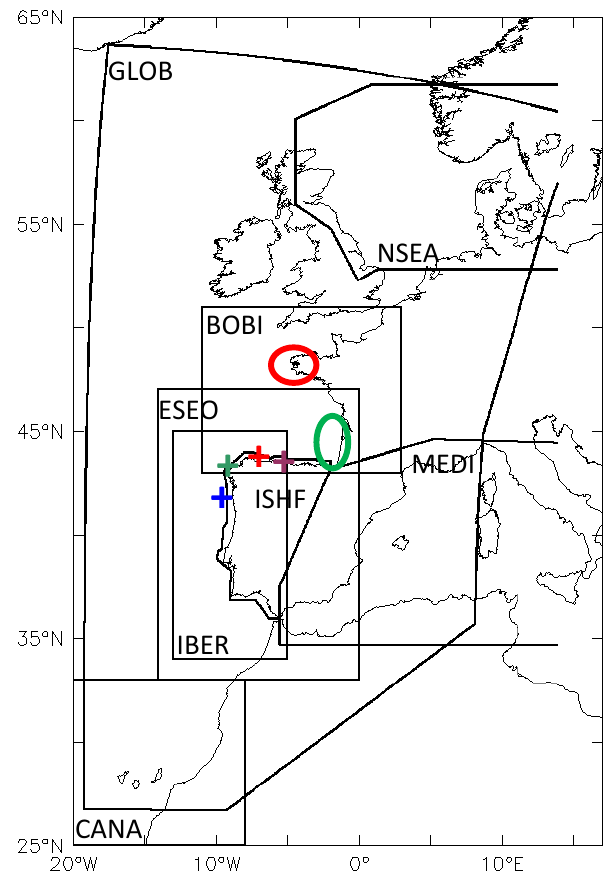
Figure 7: Map of IBI area with boxes where statistics have been calculated:Bay of Biscay region (BOBI: 11°W-3°E, 43°N-51°N), the Canary Islands region (CANA: 21°W-8°W, 25°N-33°N), the Fig. 7. Map of IBI area with boxes where statistics have been cal- culated: Bay of Biscay region (BOBI: 11 ◦ W–3 ◦ E, 43–51 ◦ N), the ESEOAT region (ESEO: 14°W-0°E, 33°N-47°N), the Iberic Peninsula region (IBER: 13°W-5°W, 34°N- Canary Islands region (CANA: 21–8 ◦ W, 25–33 ◦ N), the ESEOAT 45°N), the Iberic Peninsula shelf region (ISHF: IBER region over the shelf), the Mediterranean Sea region (ESEO: 14 ◦ W–0 ◦ E, 33–47 ◦ N), the Iberic Peninsula re- region (MEDI: from Gibraltar strait to 9°E), the North Sea region (NSEA: 12°W-14°E, 48°N-62°N) and gion (IBER: 13–5 ◦ W, 34–45 ◦ N), the Iberic Peninsula shelf region the IBI domain region (GLOB). The colored crosses corresponds to the moorings: CaboSilleiro in blue (ISHF: IBER region over the shelf), the Mediterranean Sea region (9.39°W, 42.13°N), Villano-Sisargas in green (9.21°W, 43.5°N), Estaca de Bares in red (7.62°W, (MEDI: from Gibraltar strait to 9 ◦ E), the North Sea region (NSEA: 44.06°N), Cabo de Penas in brown (6.17°W, 43.74°N).The red circle corresponds to the area of the 12 ◦ W–14 ◦ E, 48–62 ◦ N) and the IBI domain region (GLOB). The Ushant front and the green one corresponds to the Aquitaine and the Landes coasts. colored crosses corresponds to the moorings: Cabo Silleiro in blue (9.39 ◦ W, 42.13 ◦ N), Villano-Sisargas in green (9.21 ◦ W, 43.5 ◦ N), Estaca de Bares in red (7.62 ◦ W, 44.06 ◦ N), Cabo de Penas in brown (6.17 ◦ W, 43.74 ◦ N). The red circle corresponds to the area of the Ushant front and the green one corresponds to the Aquitaine and the Landes